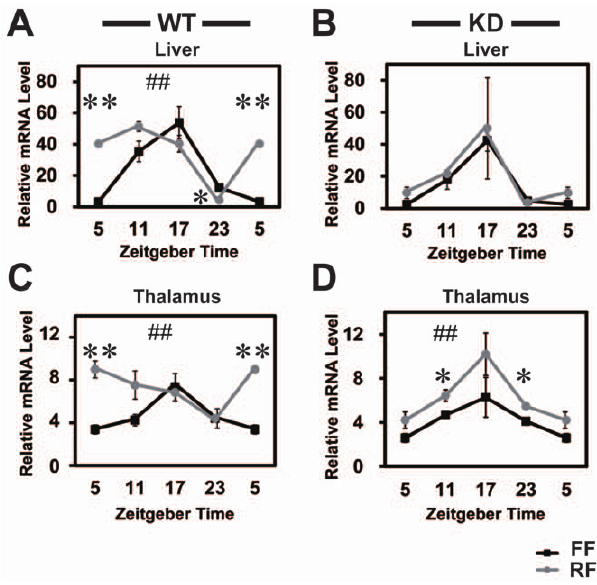
Figure 5. Daytime-RF phase-advanced circadian rhythms of Per2 in liver and thalamus in WT, but not in the KD mice. Under RF (ZT6-10), the WT mice liver ( A ) and thalamus ( C ) phase-advanced Per2 rhythms by 6 hours and 12 hours, respectively, as compared to the control mice under FF. In contrast, the circadian phase of Per2 in the KD mice was not shifted in either liver ( B ) or thalamus ( D ) by RF. ## P , 0.01 circadian gene expression profile by 2-way ANOVA (FF vs. RF mice, A, C, D). ** P , 0.01, * P , 0.05 vs. WT (Student’s t -test). n=3–4 for each ZT point. FF, free feeding; RF, restricted feeding.